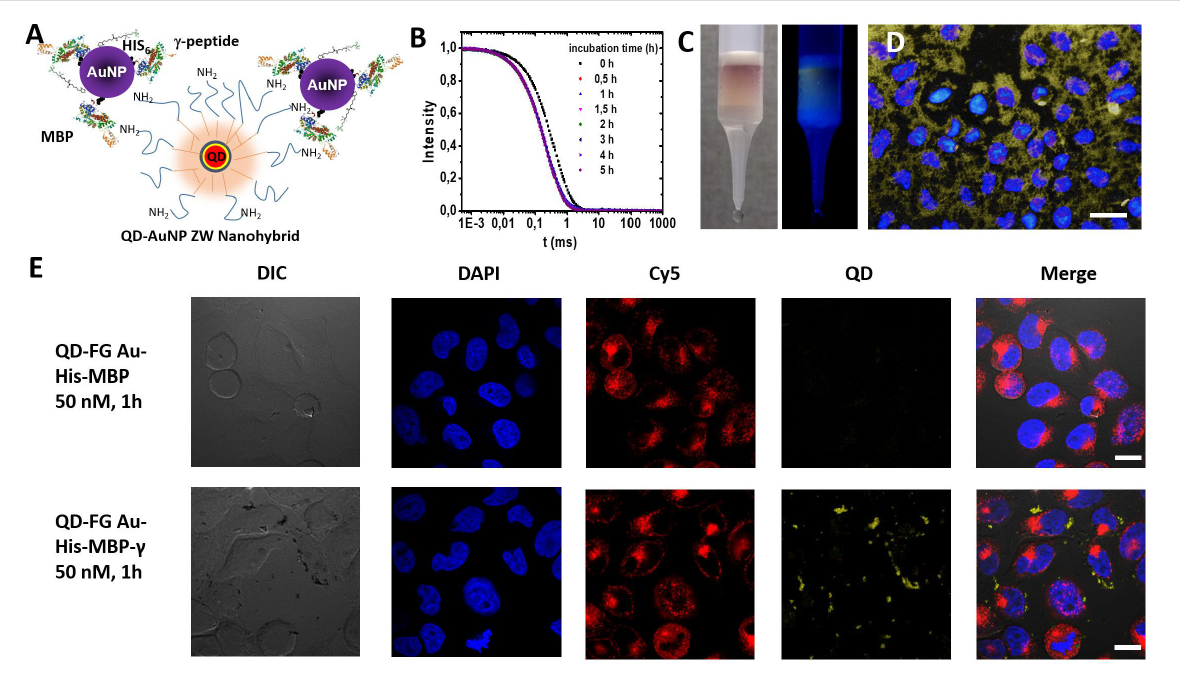
Figure 1: (A) Schematic representation of the nanohybrids (not to scale). The central QD (red, yellow, blue = core/shell/shell) is embedded in a cross- linked polymer micelle, consisting of a hydrophobic block (red) and an amphiphilic block (PEO). Interaction of the QDs with AuNPs (purple) is driven by the amine functional group. Gold nanoparticles are His-conjugated to His 6 -MBP- γ . The entire nanohybrid has a hydrodynamic diameter of ≈ 90 nm. (B) Profiles of the intensity autocorrelation function, collected from a dispersion of the nanohybrids in Dulbecco's Modified Eagle Medium (DMEM) media, at various time intervals over a period of 5 h. The profiles are unchanged, indicating colloidal stability. (C) Binding of the nanohybrids (presenting MBP- γ ) onto an amylose column; the fluorescent and pinkish band reflect the presence of QDs and AuNPs. (D) A representative epifluo- rescence image of fixed HeLa cells after incubation with the nanohybrids at c (QD) = 100 nM and 14 His 6 -MBP- γ equiv/AuNP, scale bar = 50 µm. (E) Confocal microscopy images of HeLa cells incubated with nanohybrids for 1 h; c (QD) = 50 nM and 7 His 6 -MBP- γ equiv/AuNP. 60× magnification was used. Scale bar = 20 µm. (Top panels) data correspond to nanohybrids containing His 6 -MBP (no γ -peptide); (bottom panels) correspond to nanohybrids with His 6 -MBP- γ . Shown are differential interference contrast (DIC), 4 ′ ,6-Diamidino-2-phenylindol (DAPI), Cy5-red, and yellow QD chan- nels, along with the merged images. Figure 1A adapted with permission from [8], copyright 2016 American Chemical